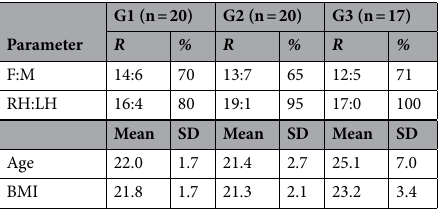
Table 3. Demographics. G1 = group 1; G2 = group 2; G3 = group 3; F = female; M = male; RH = right-handed; LH = left-handed; BMI = body mass index; R = ratio; SD = standard